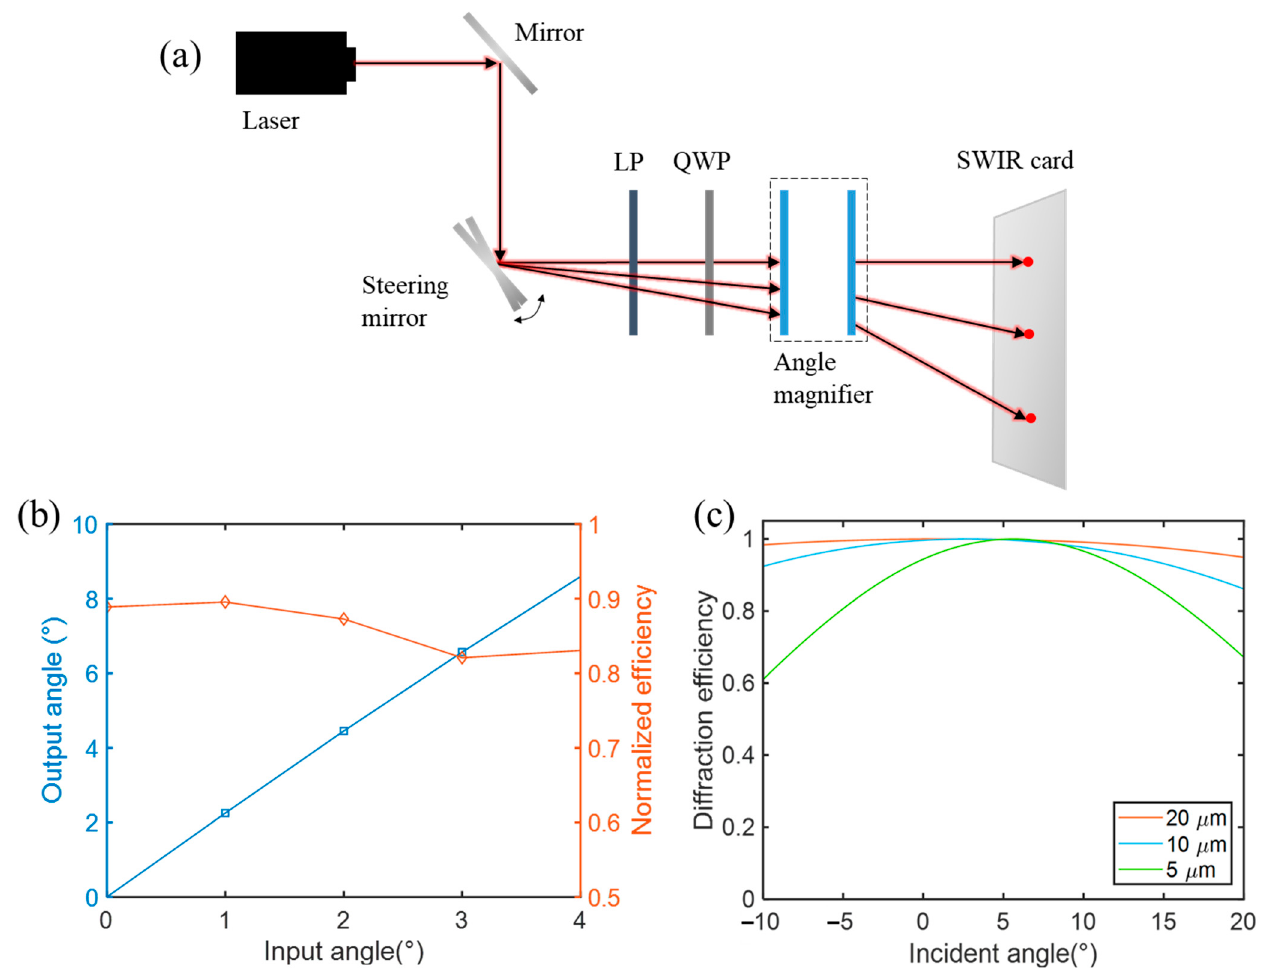
Figure 4. ( a ) Schematic of the measurement setup. LP: linear polarizer; QWP: quarter-wave plate. The incident angle is tuned from 0° to 4°. ( b ) Performance of the beam angle expander. Dots represent the measured data and solid lines are visual guides. ( c ) Simulated angle-dependent efficiency of non-twist LC PB elements. Local grating period: 5 µm, 10 µm, and 20 µm.